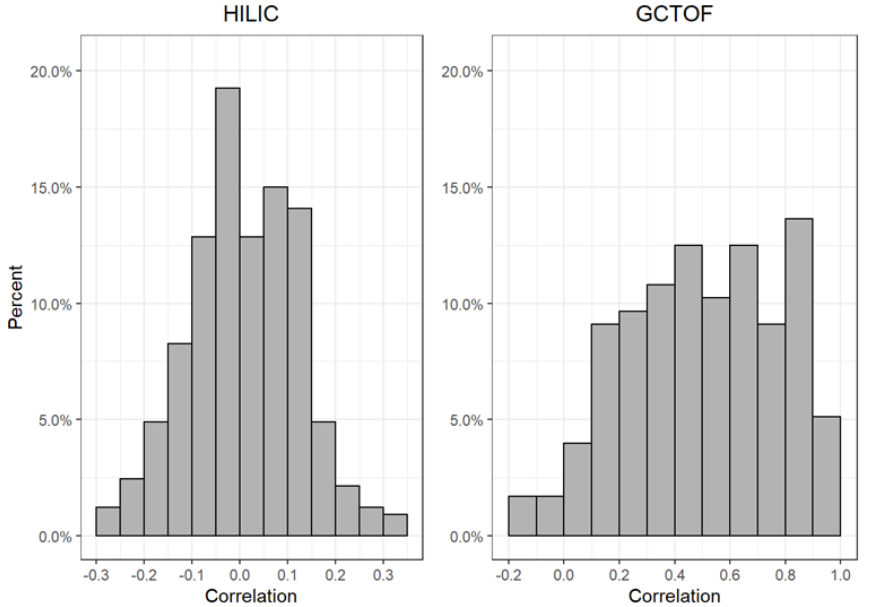
Figure 1. Histograms of the distribution of between-biospecimen correlations of all metabolites in the true HILIC and GCTOF data sets.